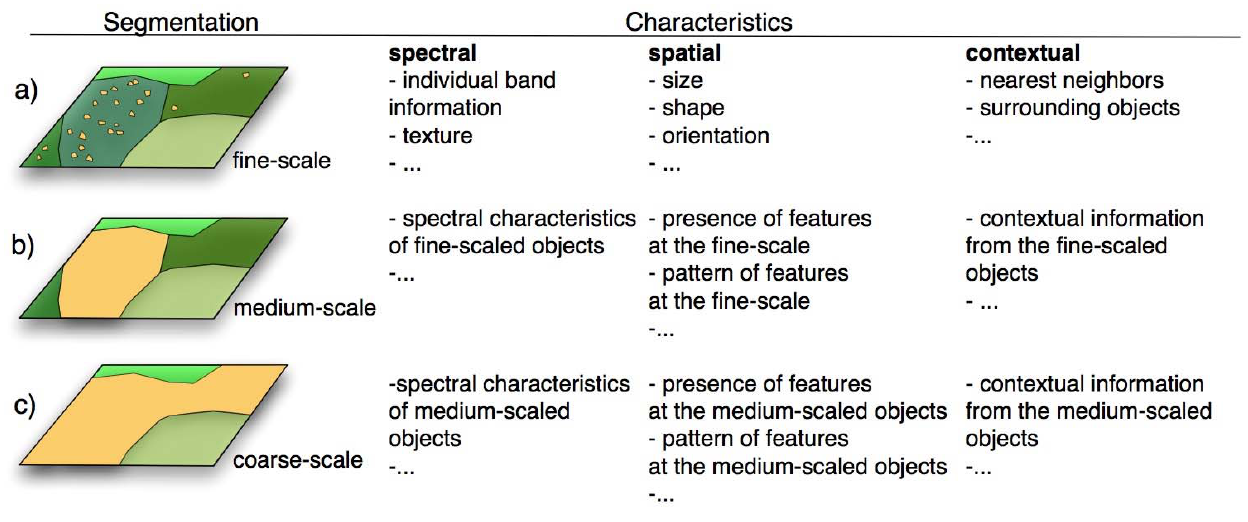
Figure 3. Conceptual diagram of the OBIA process for multi-scaled analysis of remotely sensed imagery. (a) , (b) and (c) are different levels of image segmentation (fine-scale to coarse-scale); they are hierarchical. At each scale the target is highlighted in orange. The characteristics are those spectral, spatial and contextual measures that can be used to classify an object. Only a few examples of characteristics within each category are listed, but there are many valuable measures at each scale that can be used for analysis depending on the research question (e.g., average, minimum, maximum, composite indexes, etc. ). Fine-scale characteristics can be used to classify medium-scale features and so